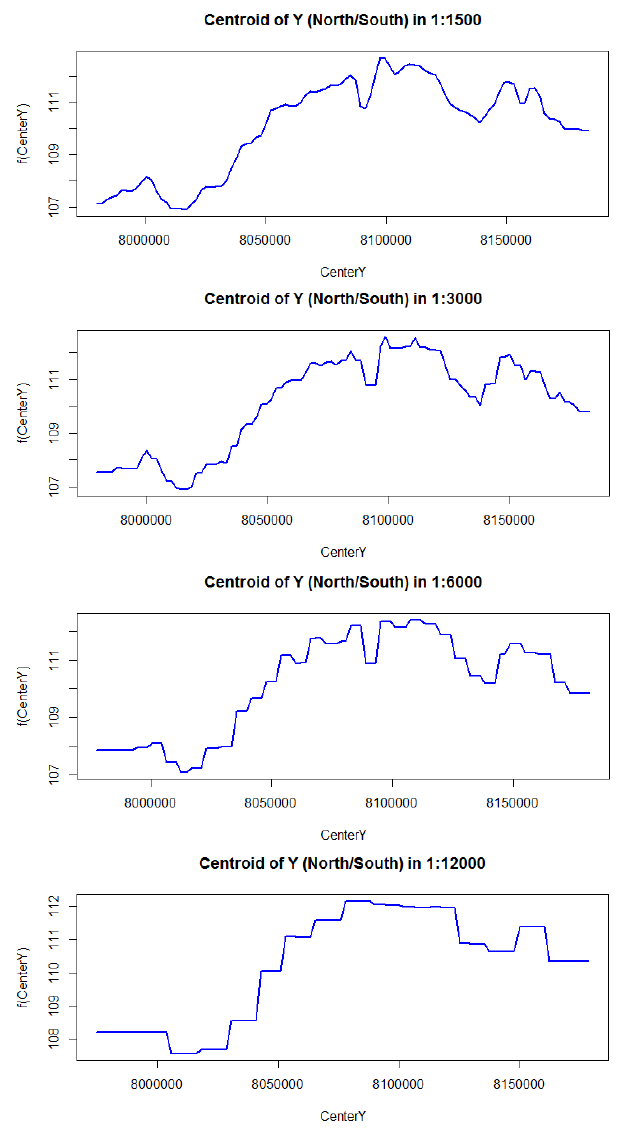
Figure A1. Partial dependency plots in 1500 m to 12,000 m from top to bottom of best year 1990. The effect of latitude (CenterY) show similar patterns for the resolution of 3000 m and 6000 m, with a steep linear increase in FCover after a threshold